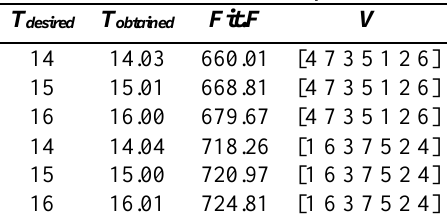
Table 4. The results of the experiments